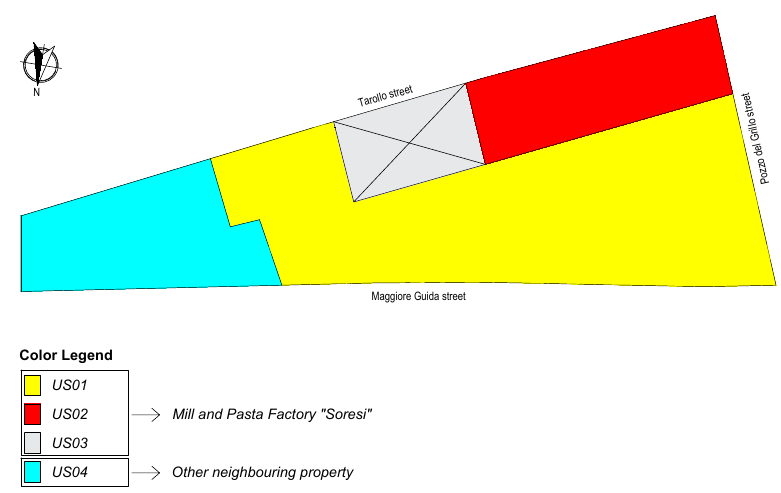
Figure 13. Identification of Structural Units.